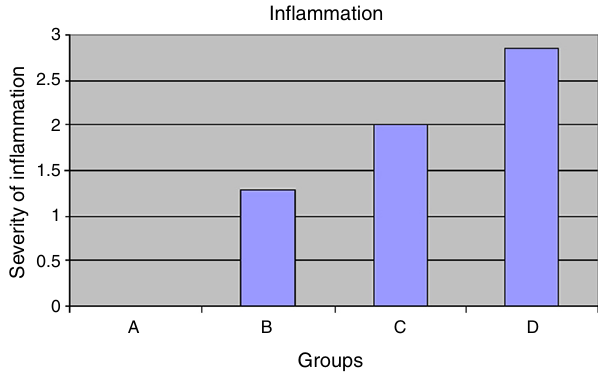
A, B, C, D groups relationship between the severity of inflammation. 0, no inflammation; 1, mild; 2, moderate; 3,